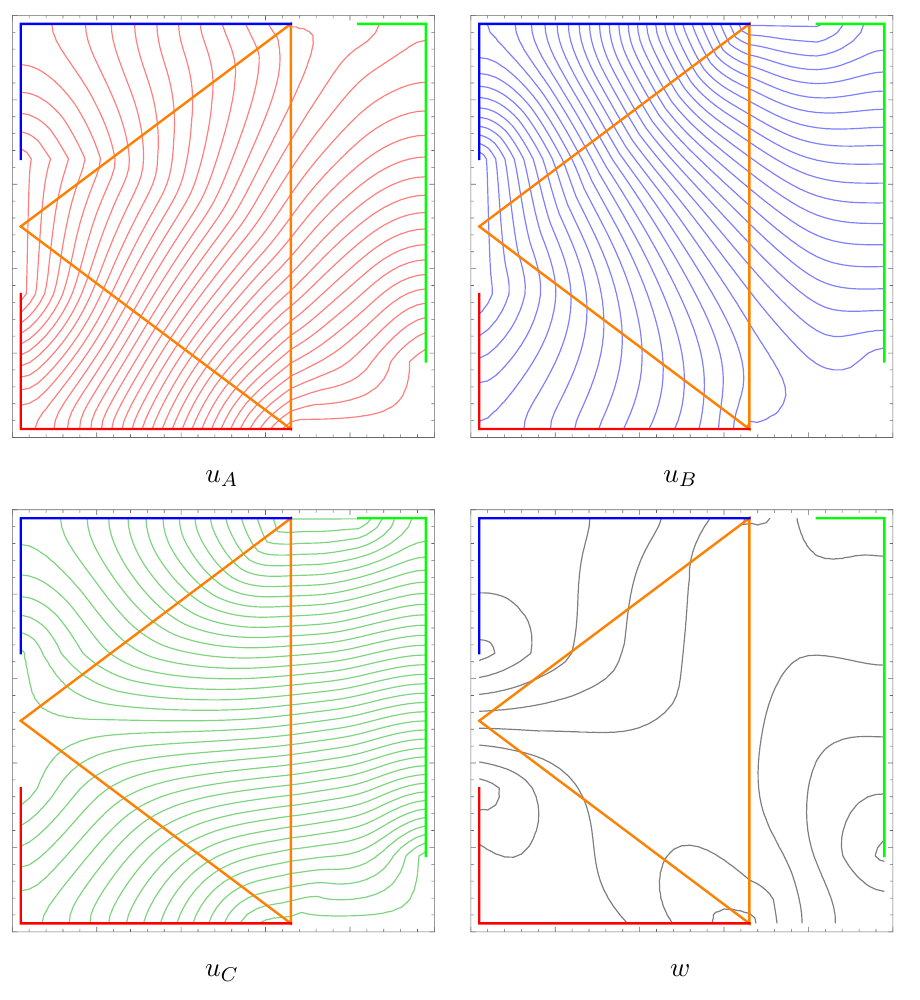
Figure 17 . The same con(cid:12)guration shown in (cid:12)gure 16, in terms of the vector (cid:12)elds